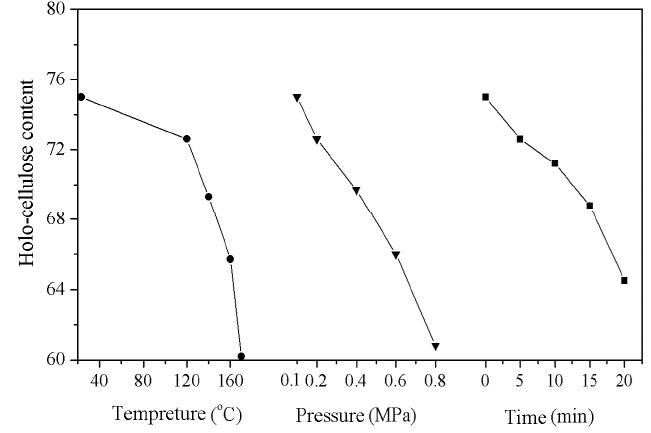
Figure 2. Effect of high temperature and pressurized steam on the hollocellulose content of wood fibers.